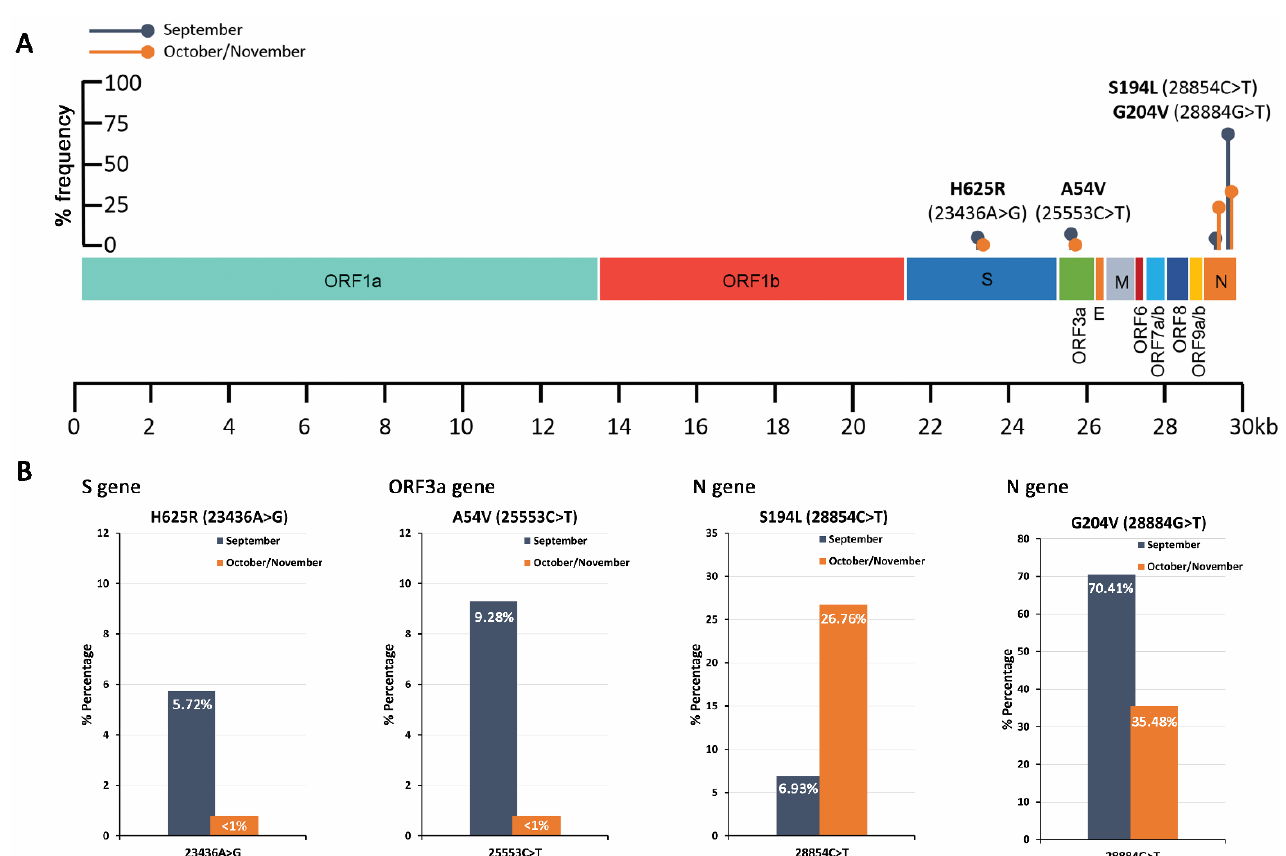
Figure 4. Schematic illustration on SARS-CoV-2 genomic map colored by genomic region ( A ) and bar plots ( B ) of the % frequency of H625R (S), A54V (ORF3a), S194L, and G204V (N) missense mutations in wastewater samples.